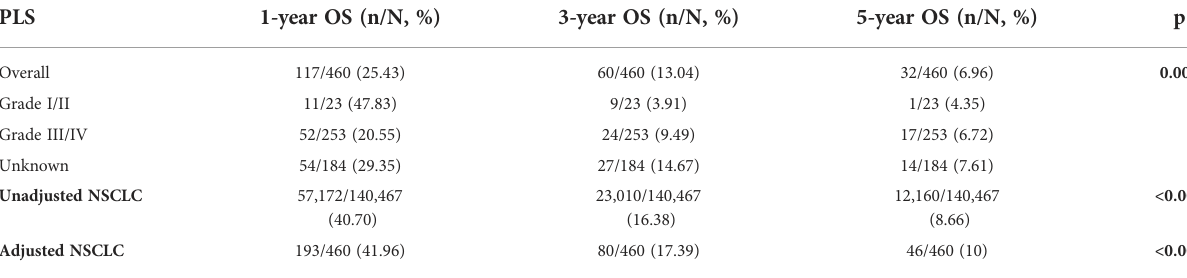
TABLE 3 Comparison of 1, 3, and 5-year OS between the PSC and NSCLC cohorts.